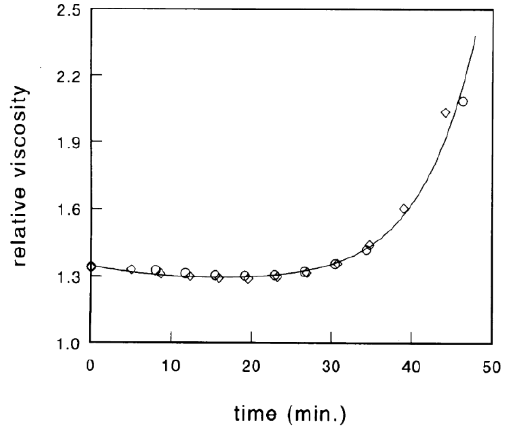
Figure 7. Relative viscosity of skim milk during the coagulation process. The drawn line represents the theoretical calculation in which the micelles are considered to be sticky hard spheres. Reproduced from [50]. with permission from [De Kruif, C.G.], [Casein Micelle Interactions]; published by [ Int. Dairy J. ],